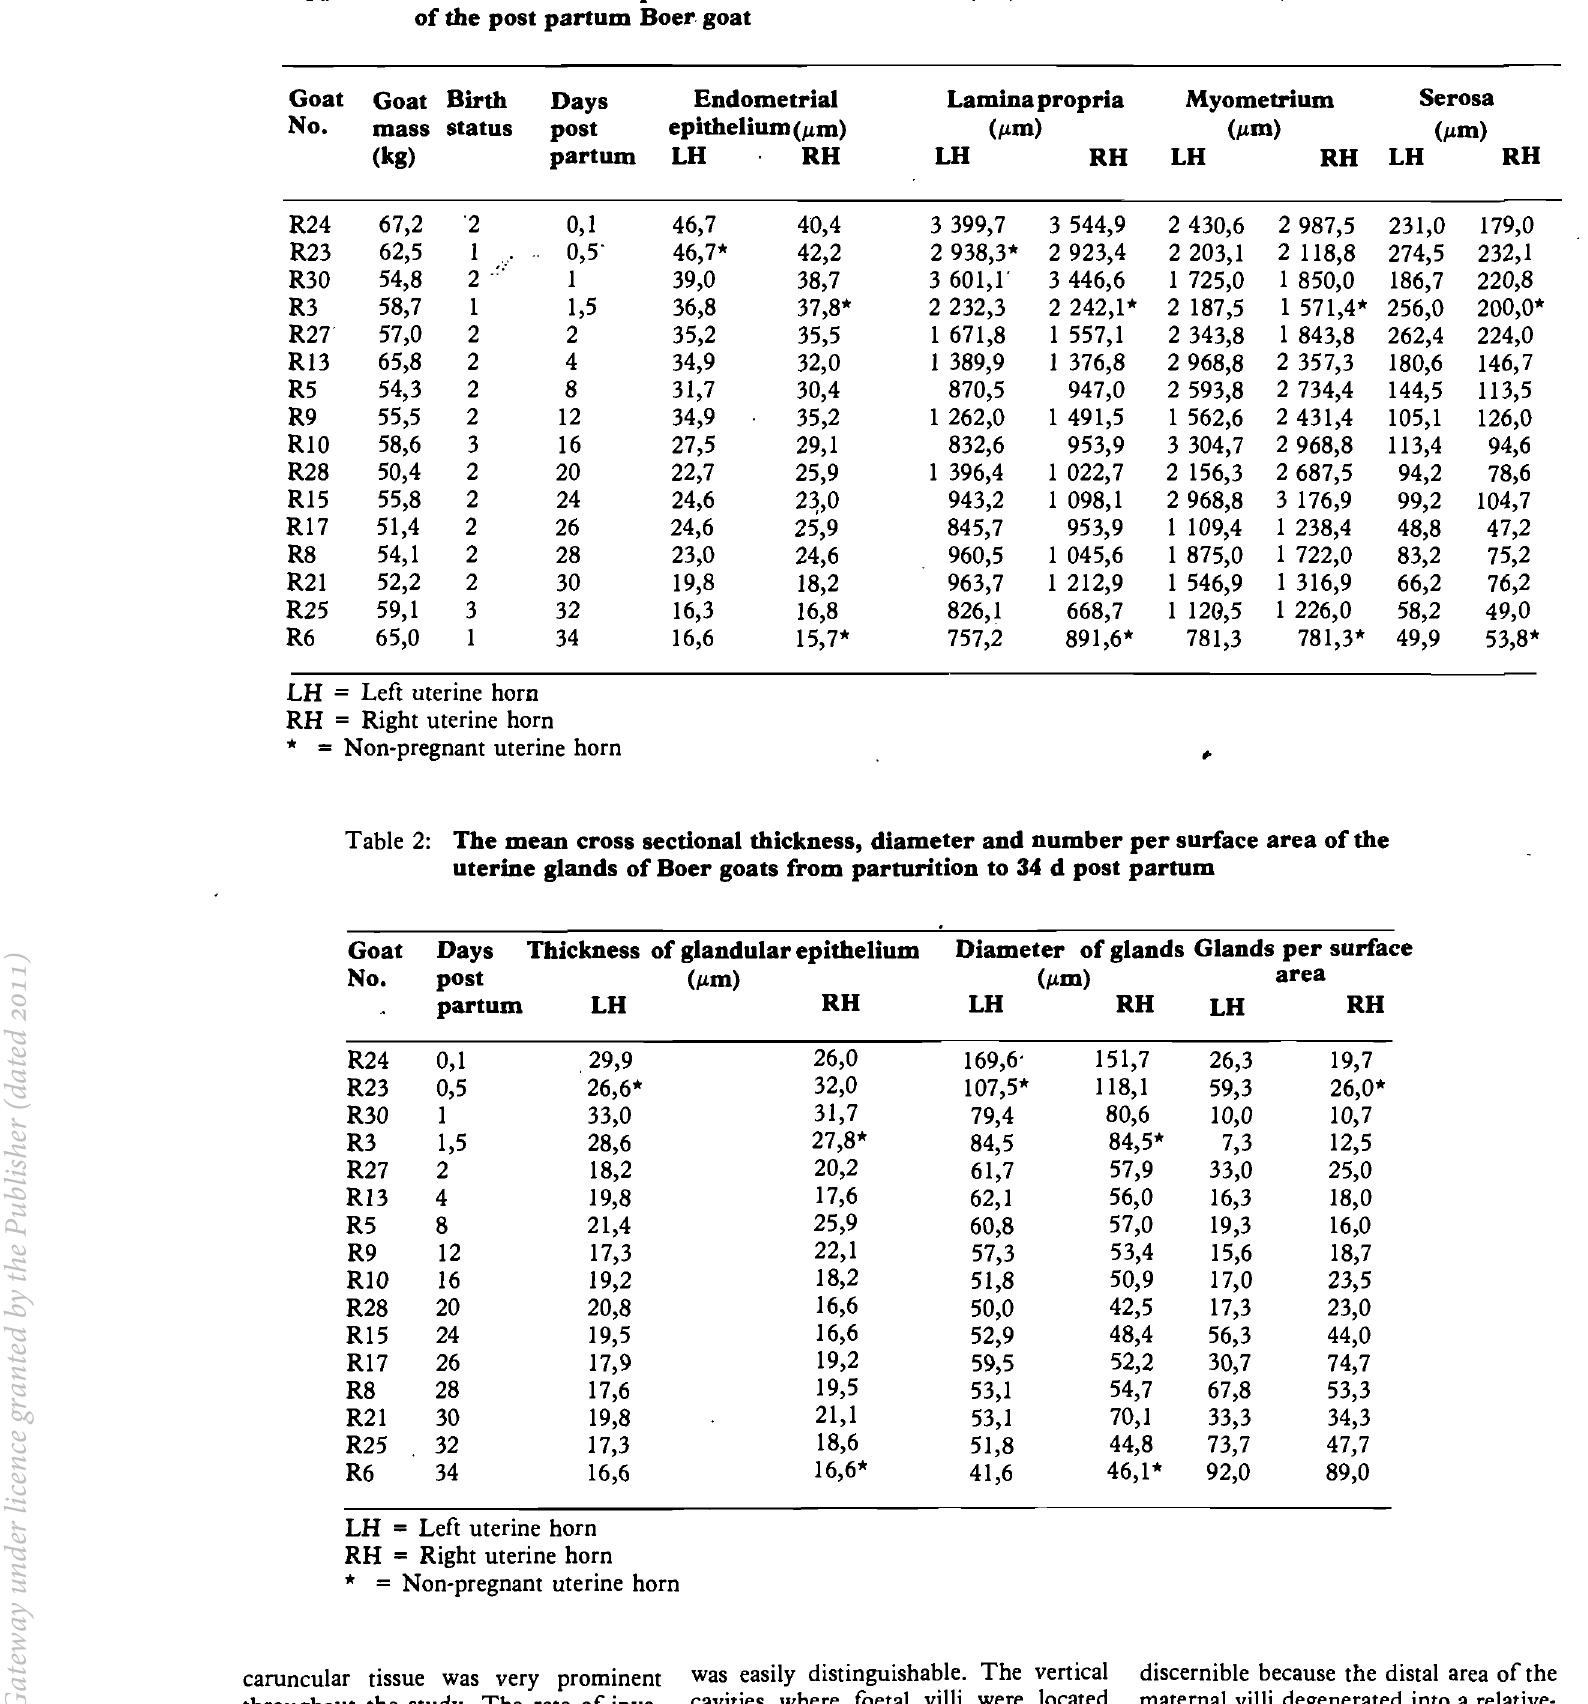
Table 1: The mean microscopic cross sectional thickness (JLm) of the different histological layers in the uterus of the post partum Boer goat Goat Goat Birth Days Endometrial Lamina propria Myometrium Serosa